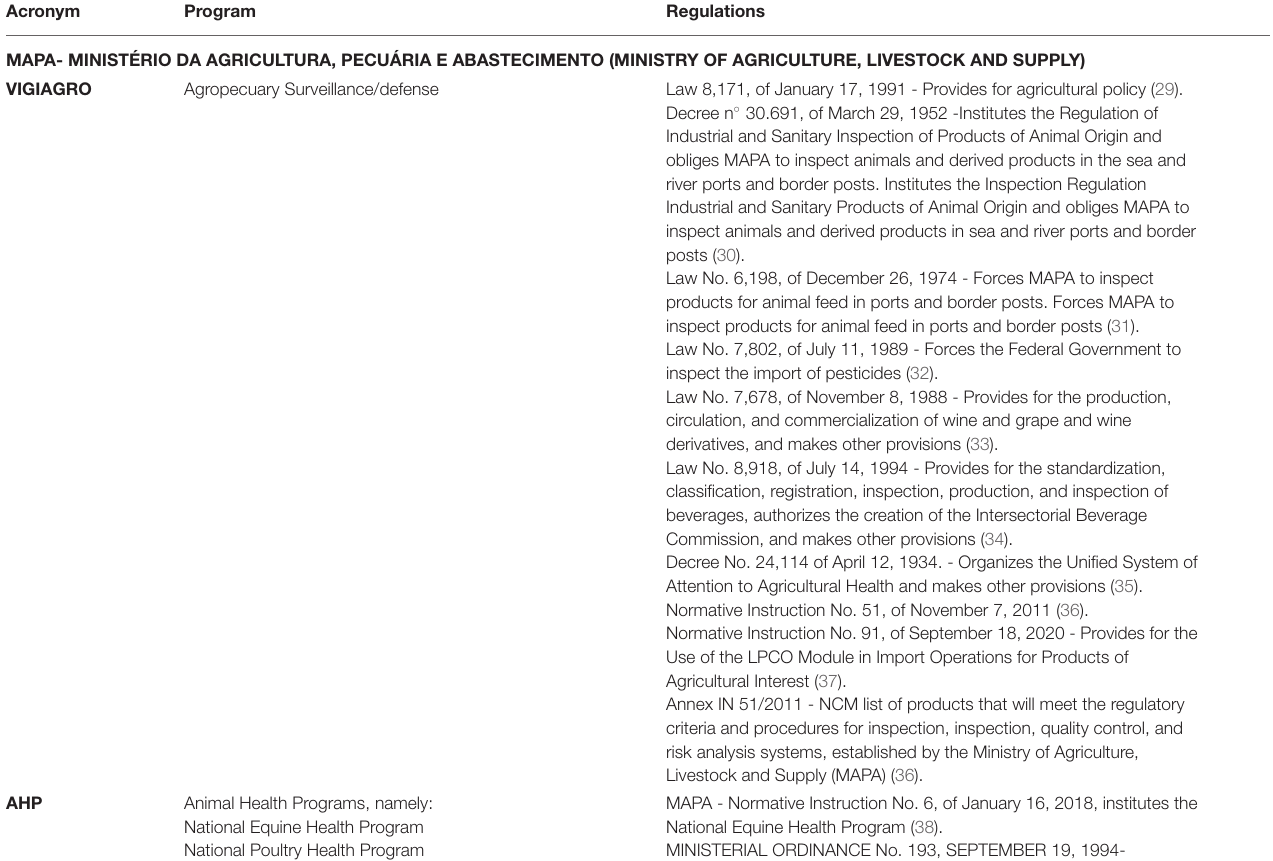
TABLE 2 | Organizational components of Health Surveillance System (HSS) programs and policies regarding the human, animal, and environmental health in Brazil.